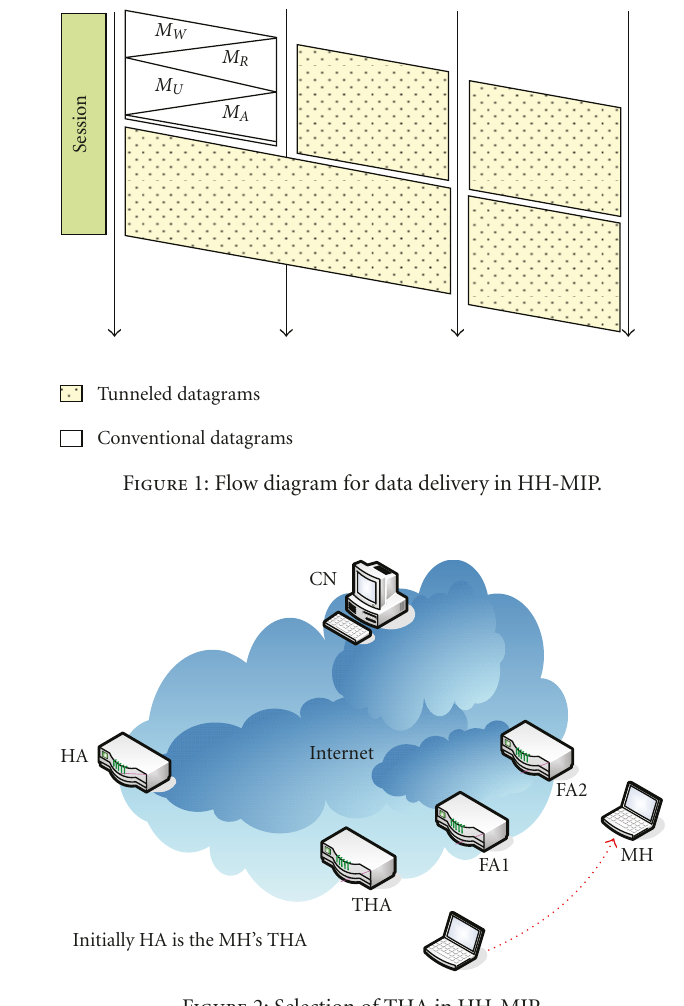
Figure 2: Selection of THA in